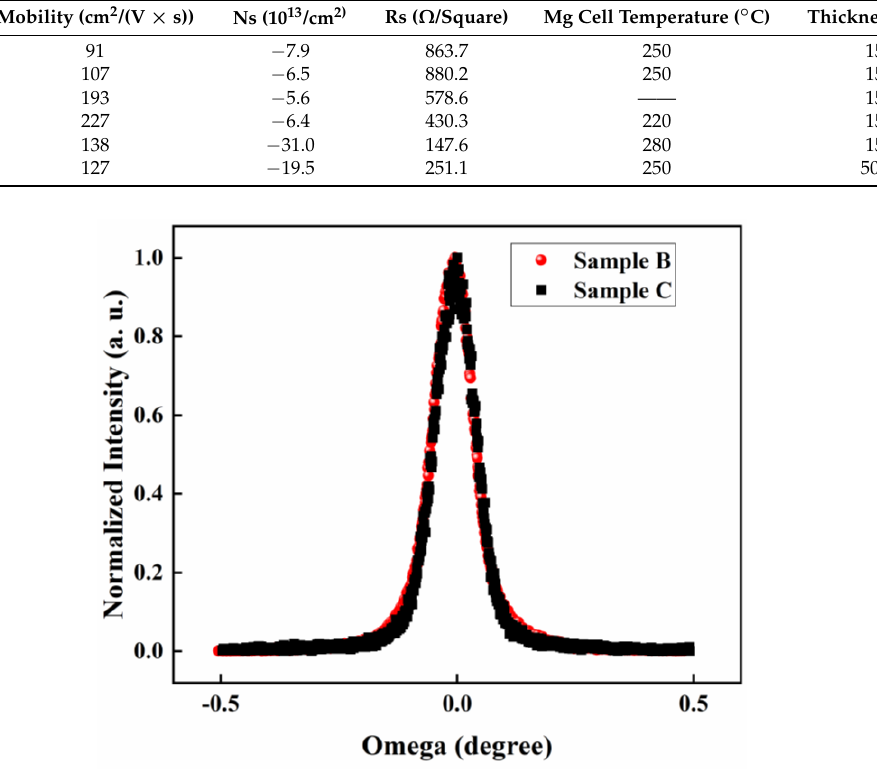
Figure 2. The XRD rocking curves of the two samples measured across (002) plane.